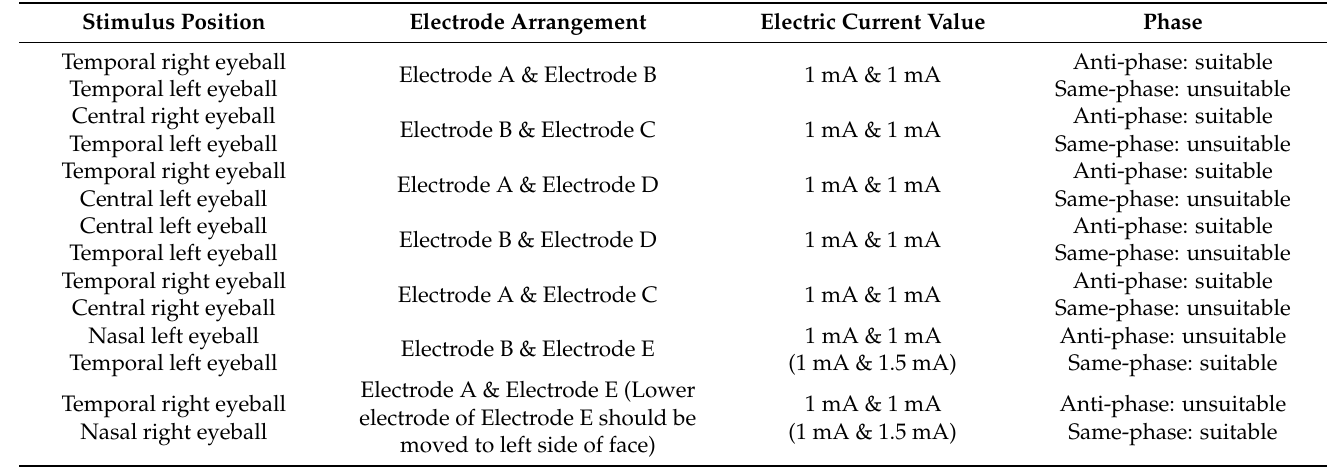
Table 1. Hypotheses about the adequate stimulation factors to stimulate lower human eyeballs with multiple electrodes.